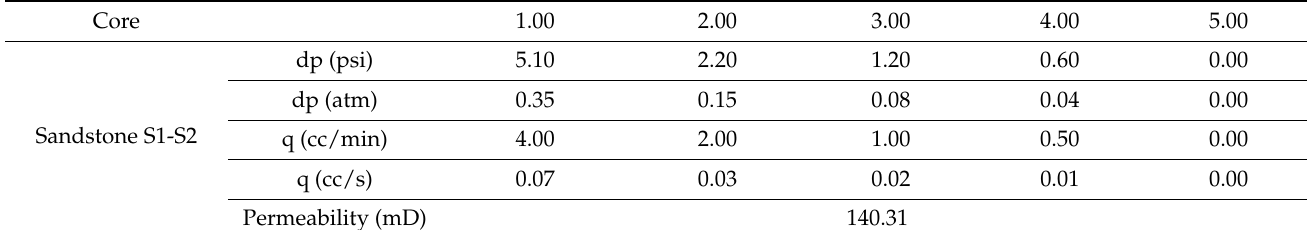
Table 2. Average Permeability